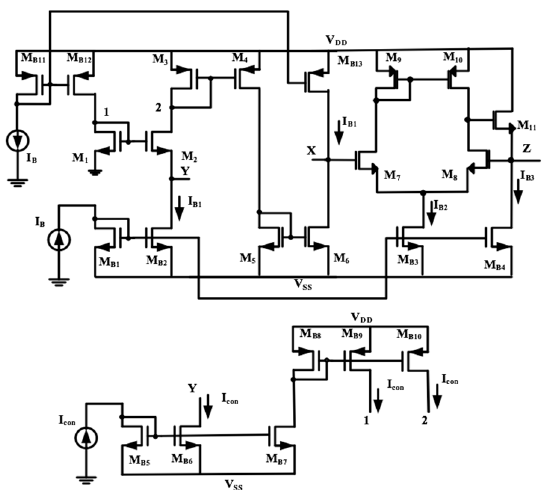
Figure 6. CMOS implementation of VCII - with electronically variable impedance at the Y port. Nodes Y, 1 and 2 from the lower section of the schematic are connected to their counterparts in the upper section of the schematic.